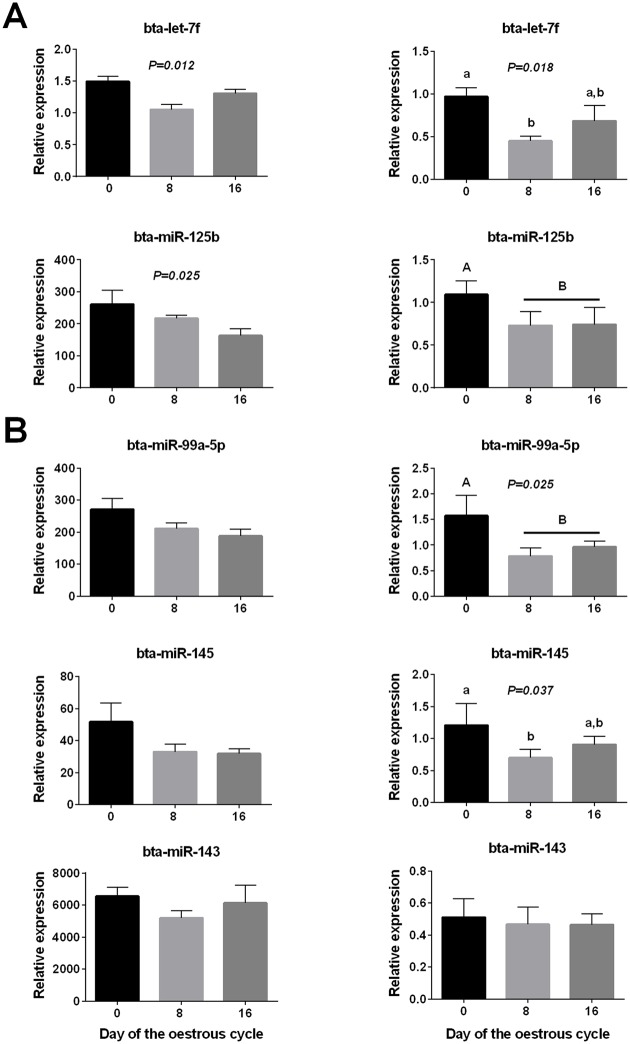
Results of RT-qPCR analyses of plasma miRNAs during the oestrous cycle (n = 8 heifers).(A) RT-qPCR validation (right column) of candidate plasma miRNAs that had been identified as differentially expressed by high-throughput analyses (small RNA sequencing or PCR array; shown in left column). (B) Expression profiles obtained by RT-qPCR (right column) of miRNAs previously reported to be differentially expressed in the ovary or endometrium during the oestrous cycle. Profiles for the same miRNAs obtained by small RNA sequencing are shown in the left column. In both (A) and (B) P-values from repeated-measures ANOVA are shown. Mean differences are indicated by different letters; a, b for P < 0.05 (Dunnett’s tests) and A, B for P < 0.1 (t-test).